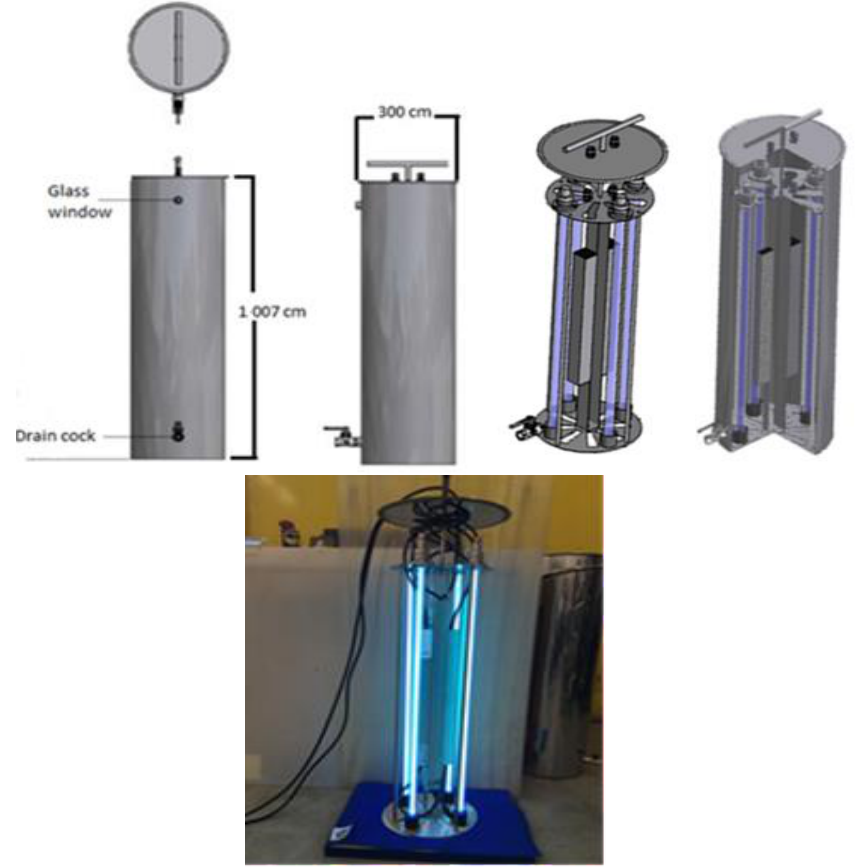
Figure 2. The portable photolytic cell. From left to right: external aspect and dimensions of the system case, scheme of the UV lamps support, the support inside the case system. Below, a photo of the completed lamps’ support.